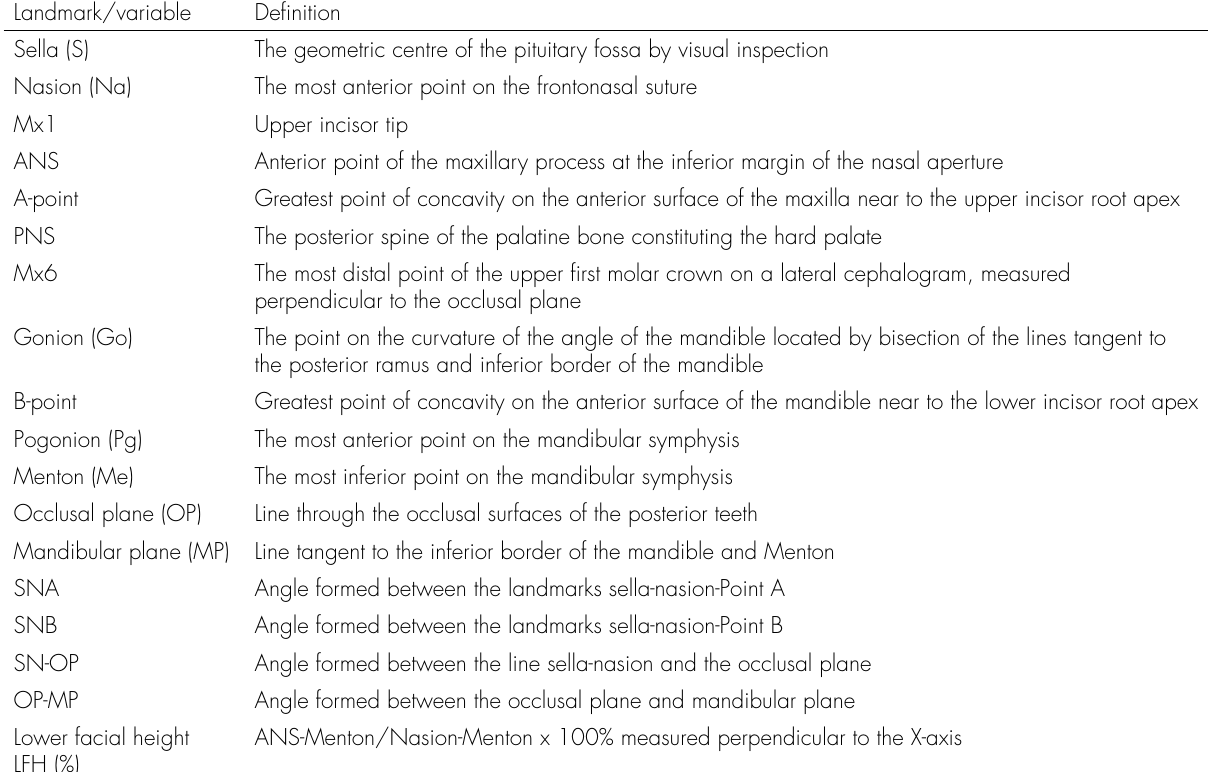
Table I. Definition of cephalometric landmarks and